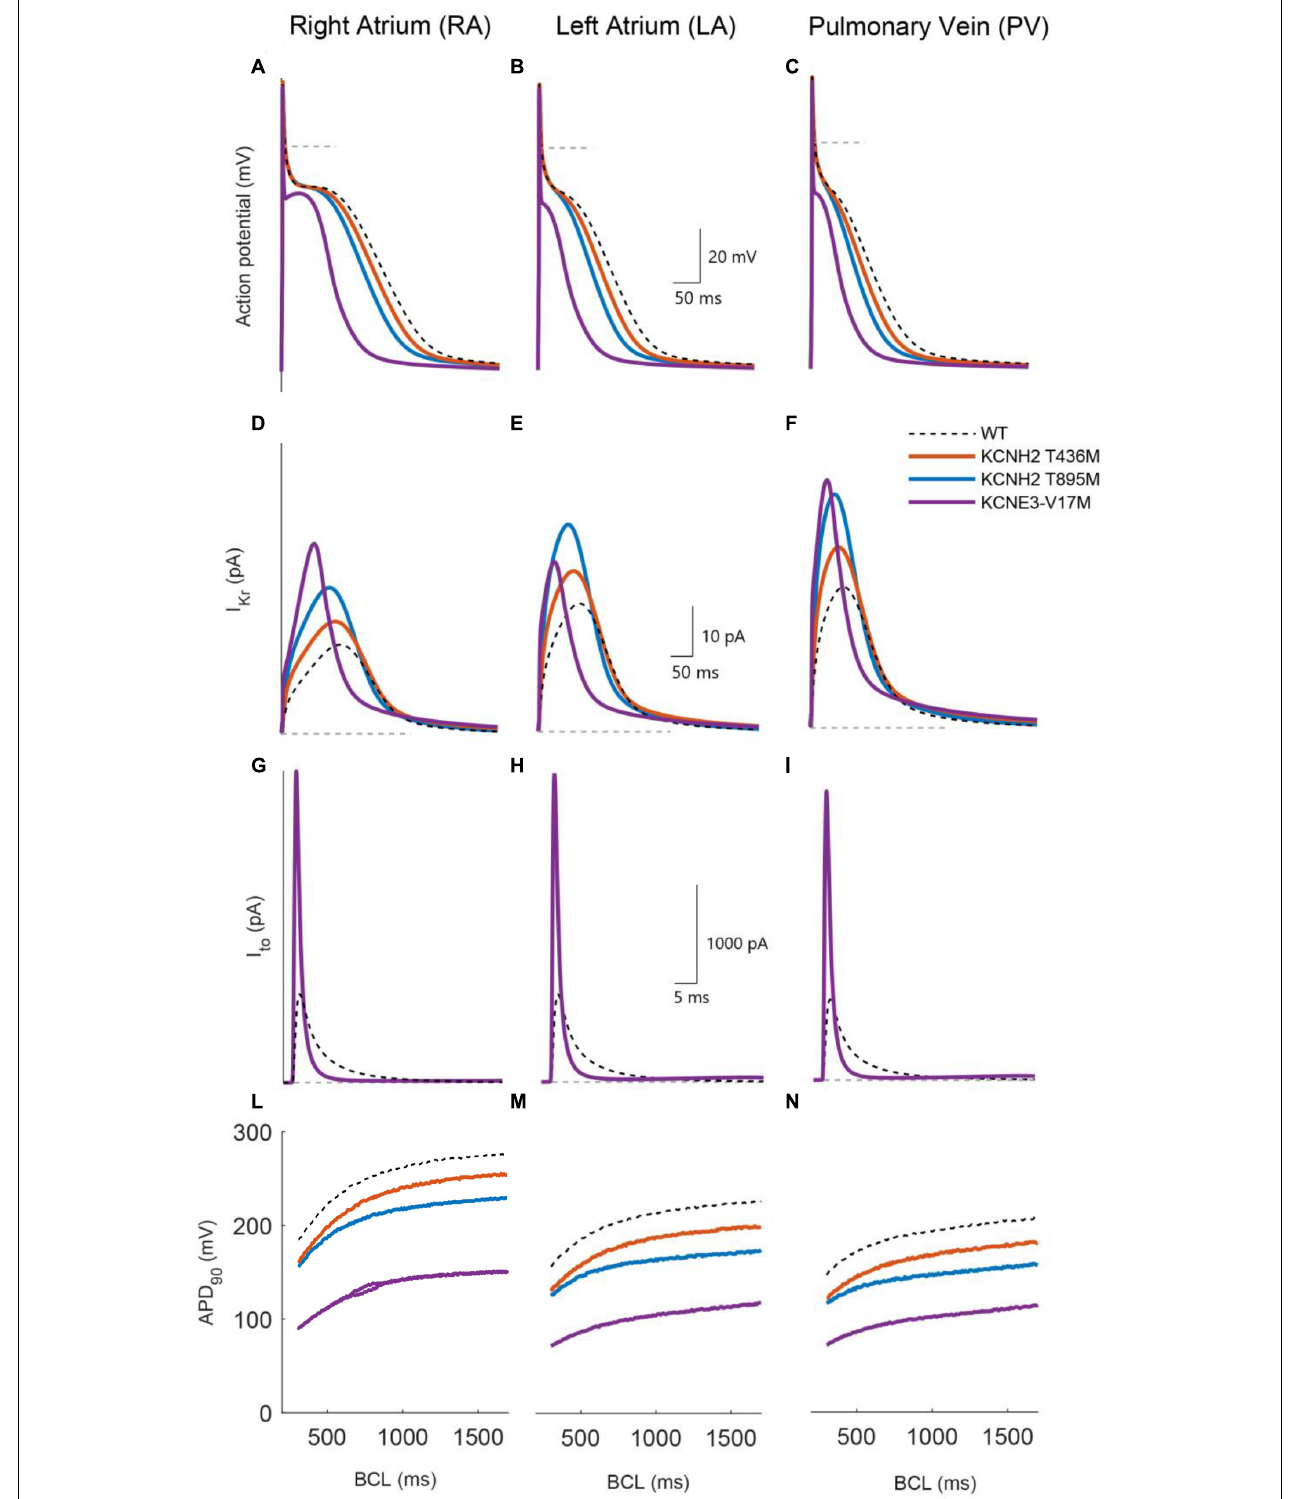
FIGURE 4 | Simulated effects of the KCNH2 T895M (blue), KCNH2 T436M (orange), and KCNE3-V17M (purple) mutations in human single cell models of right atrium, left atrium, and pulmonary vein regions (from left to right). (A–C) Action potential. (D–F) Rapid K + current. (G–I) Transient outward K + current. (L–N) APD 90 restitution curve. WT curves in dashed dark lines are included for